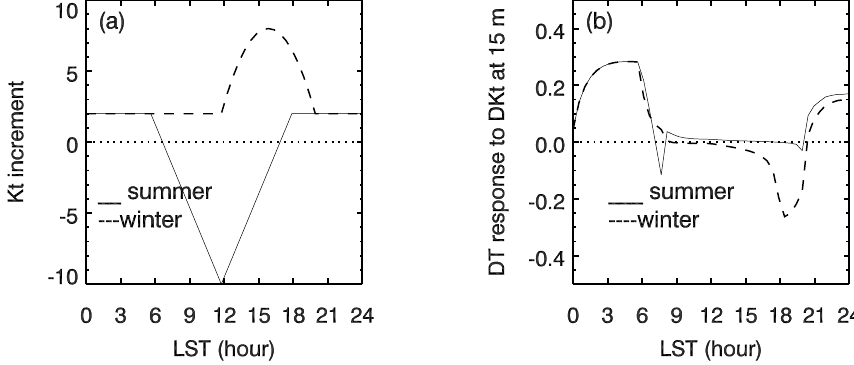
Figure 5. Diurnal variation of ∆ K ( a ), and diurnal temperature response to ∆ K t at 15 m ( b ) in the summer case (solid lines) and winter case (dashed